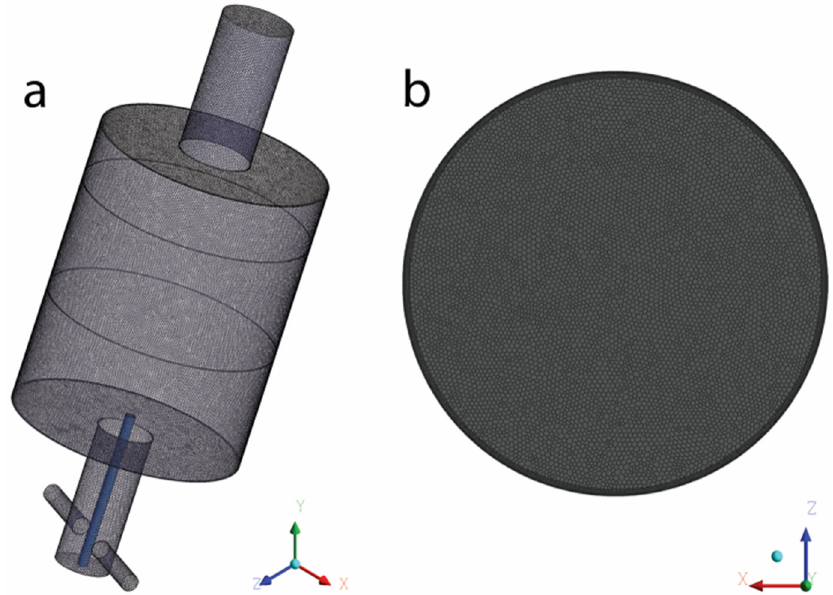
Figure 3. Mesh overview of the final mesh, 3D view of surface mesh ( a ), and top view of cross-section of the computational domain ( b ) .